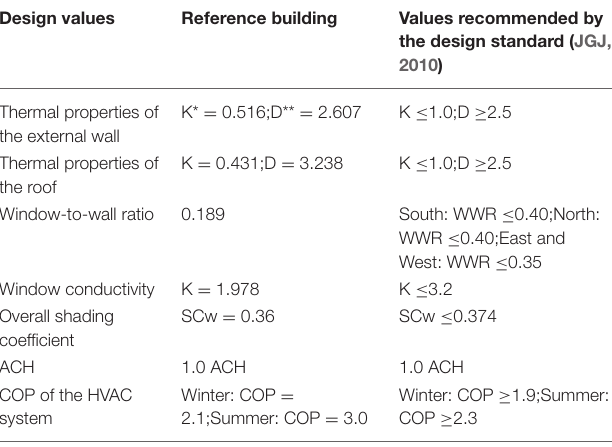
TABLE 5 | Design values of the reference building and recommend value ranges from the design standard ( JGJ, 2010). Design